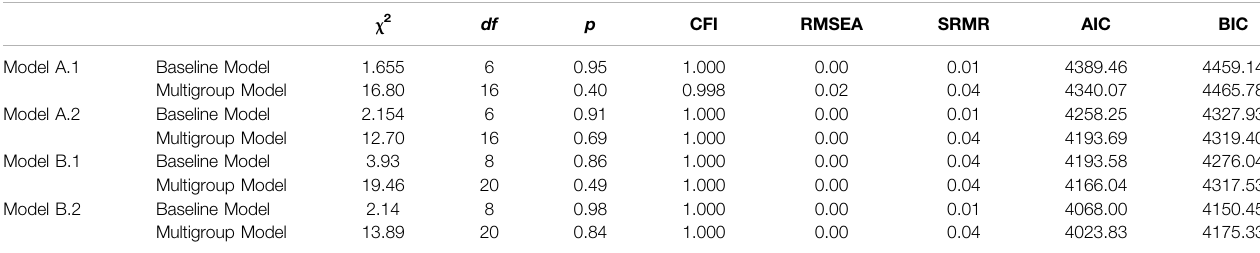
TABLE 2 | Model fi t indices across models.